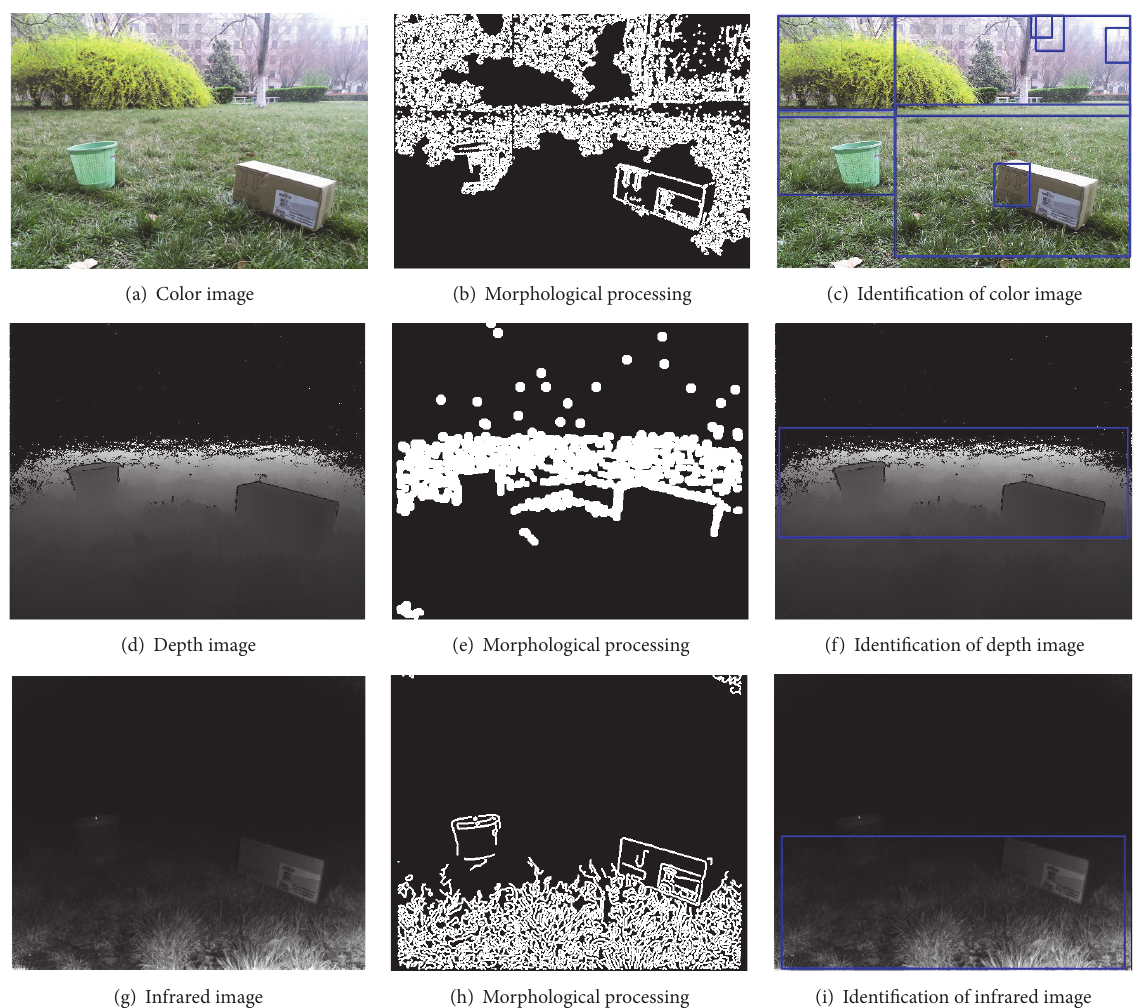
Figure 7: The results of using single image